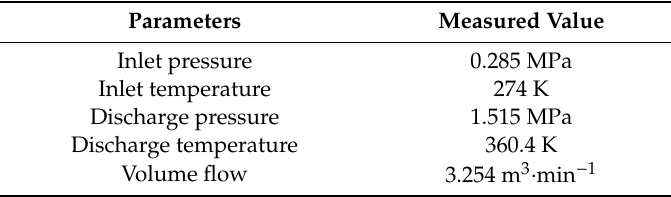
Table 1. Boundary conditions of computational fluid dynamics (CFD) simulation.